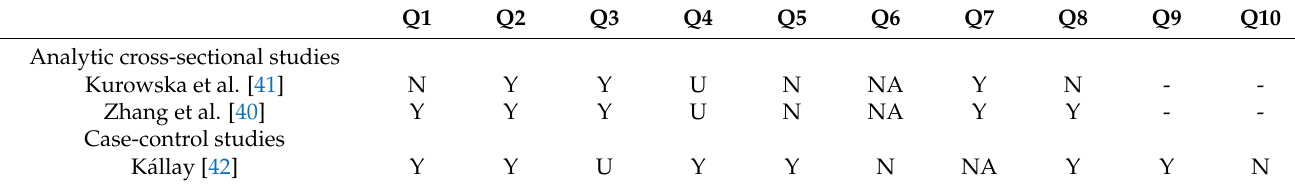
Table 2. Critical appraisal tool according to Joanne Briggs Institute